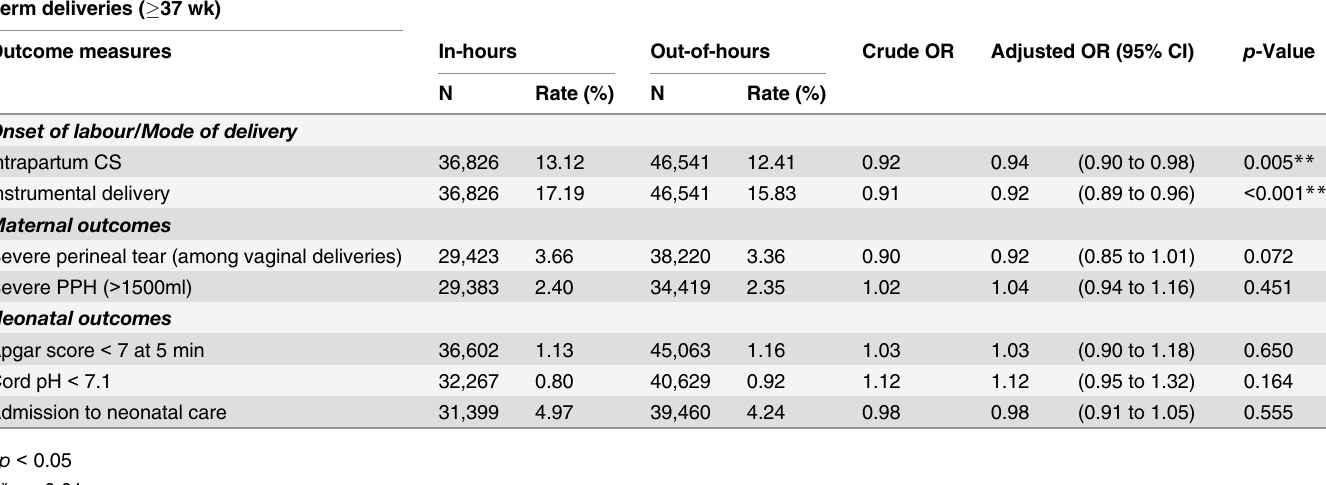
Table 3. Crude and adjusted odds ratios for adverse perinatal outcomes among term deliveries, comparing in-hours and out-of-hours. Term deliveries ( (cid:1) 37